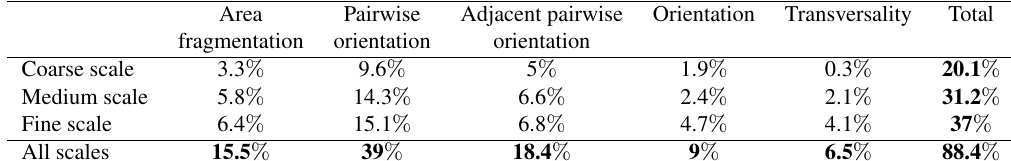
tage for classification. The shape detection on the fine scale, i.e.